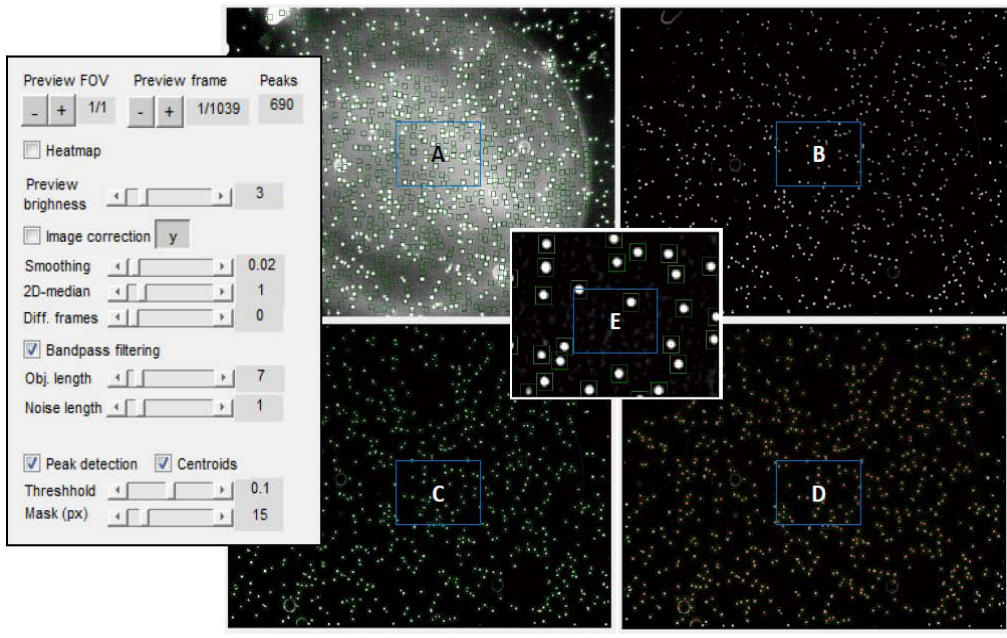
Figure 4. Graphical user interface (GUI) enabling preview of a selected frame for proper configuration of the detection parameters. This particular frame was taken from a video that recorded the Brownian motion of unloaded Dynabeads TM M-270 Carboxylic Acid. There are 690 particles detected on this frame; ( A ) is an original video frame before noise removal by applying bandpass filtering; ( B ) is an image with increased brightness; ( C ) shows a preview with detected particles (embedded in a green squared mask); ( D ) is the preview of the image with visible particles’ centroids (multiple red points). Regular spherical shapes of particles can be seen on the zoomed picture ( E ).